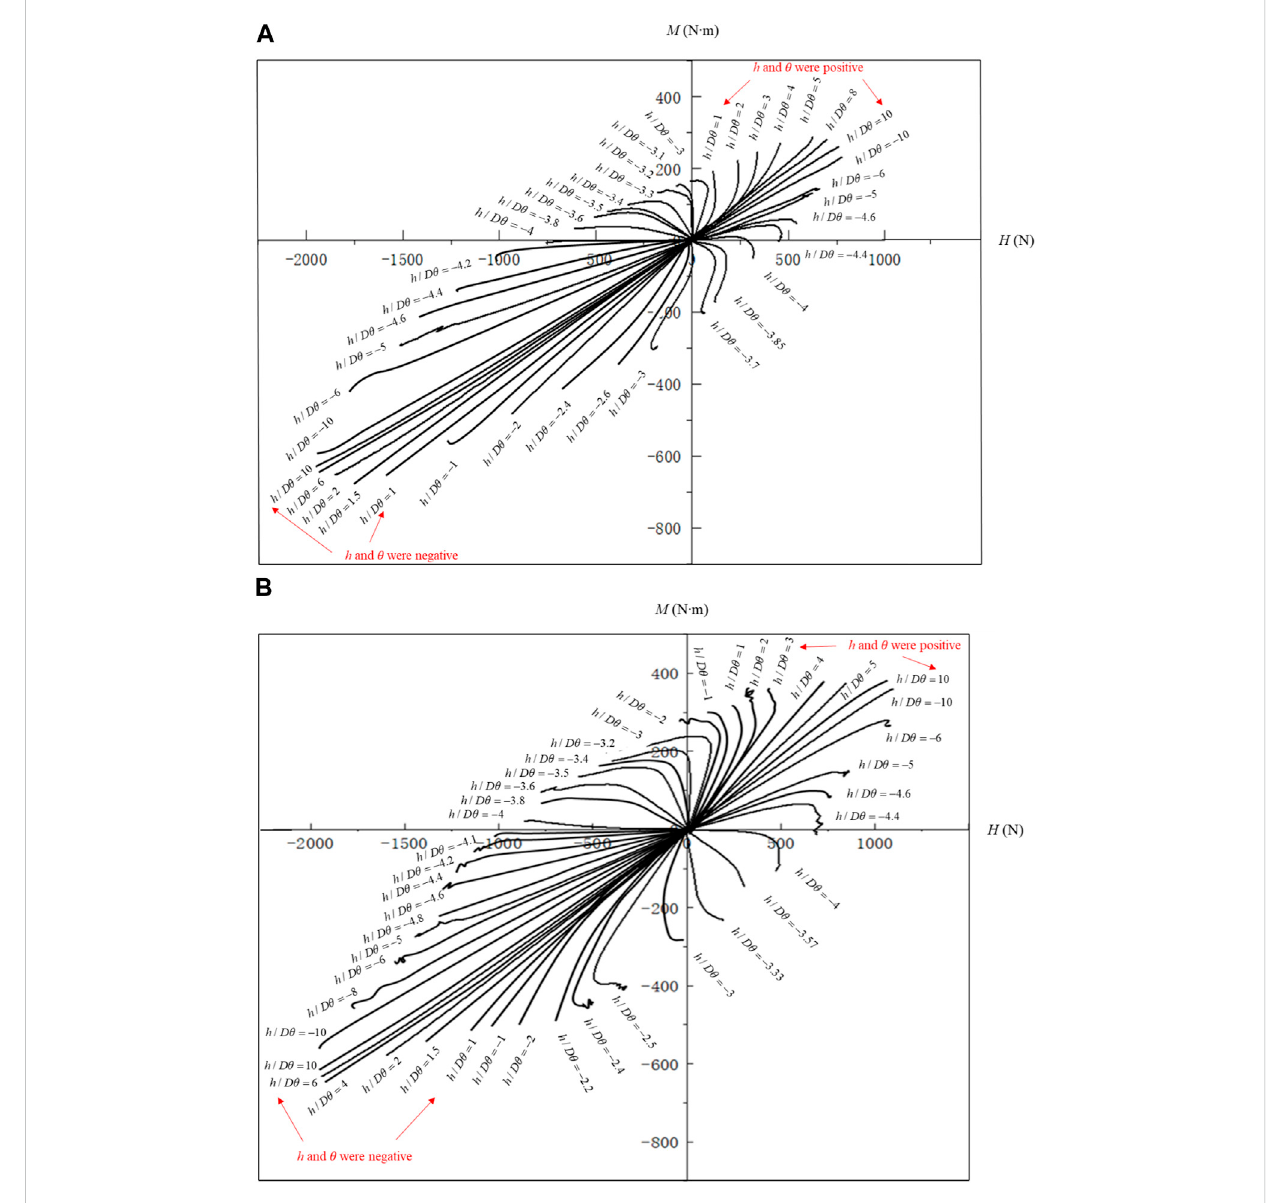
FIGURE 6 Effect of d pc on the bearing capacities of loading paths of laterally loaded single piles: (A) d pc = 0 D and (B) d pc = 4 D under different constants of d h / D d θ .